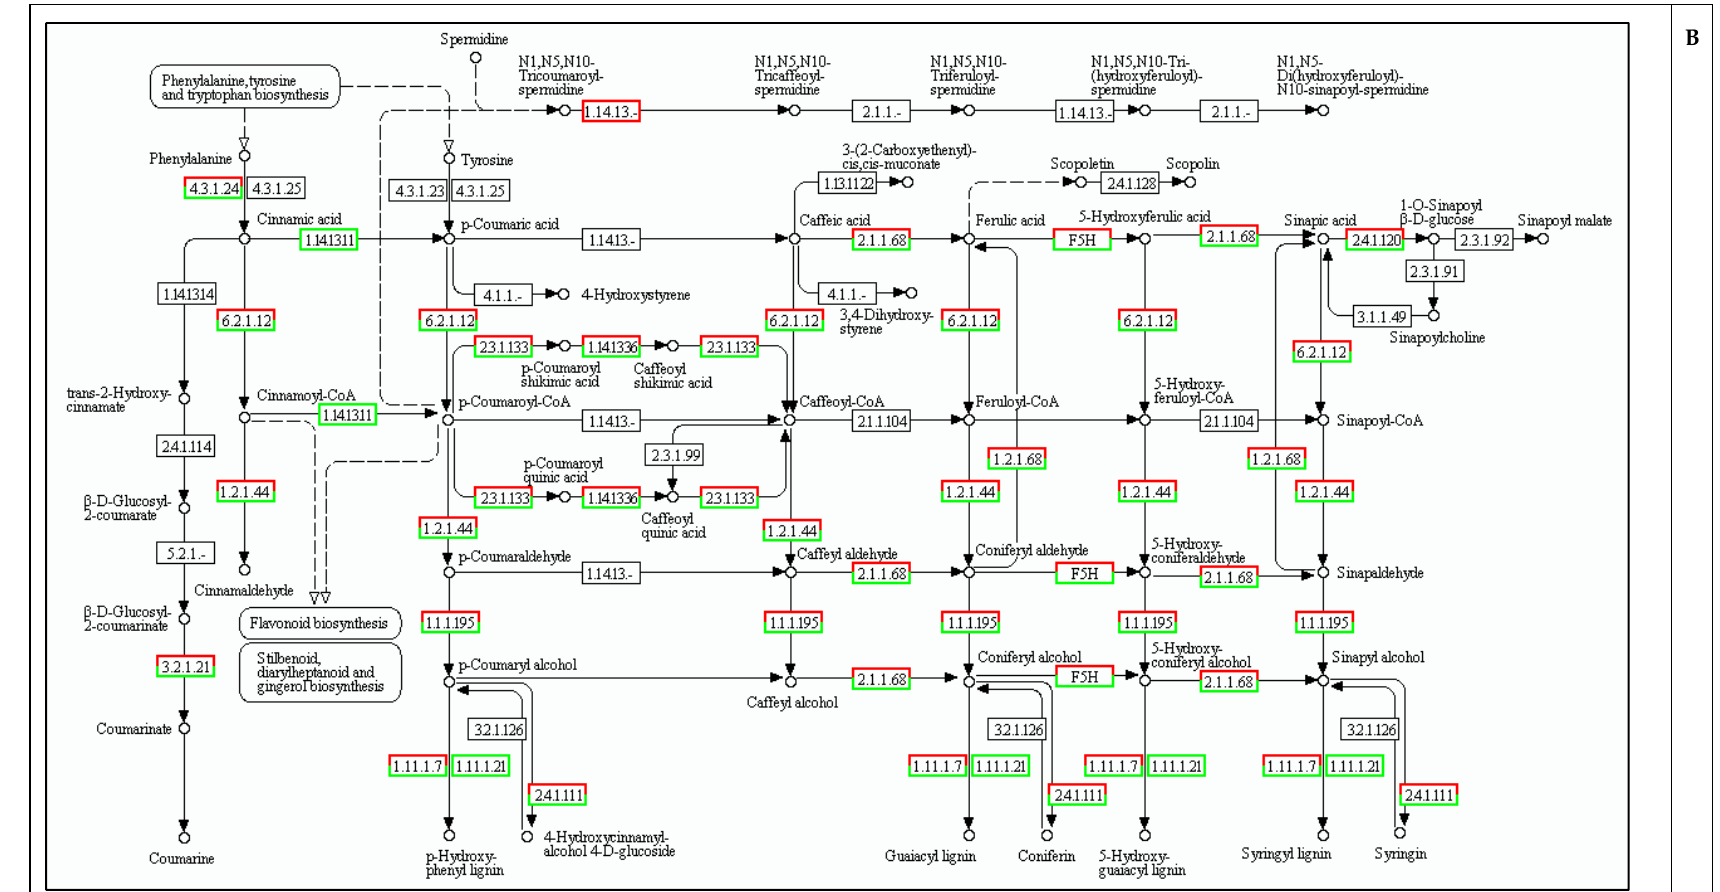
Figure 5. Plant-pathogen interactions and phenylpropanoid biosynthesis pathways induced by sodium nitroprusside treatment (SNP, NO donor). Black borders: Pathway; Red represents up-regulated genes; Green represents up-regulated genes. ( A ) Plant-pathogen interaction; ( B ) Phenylpropanoid biosynthesis.